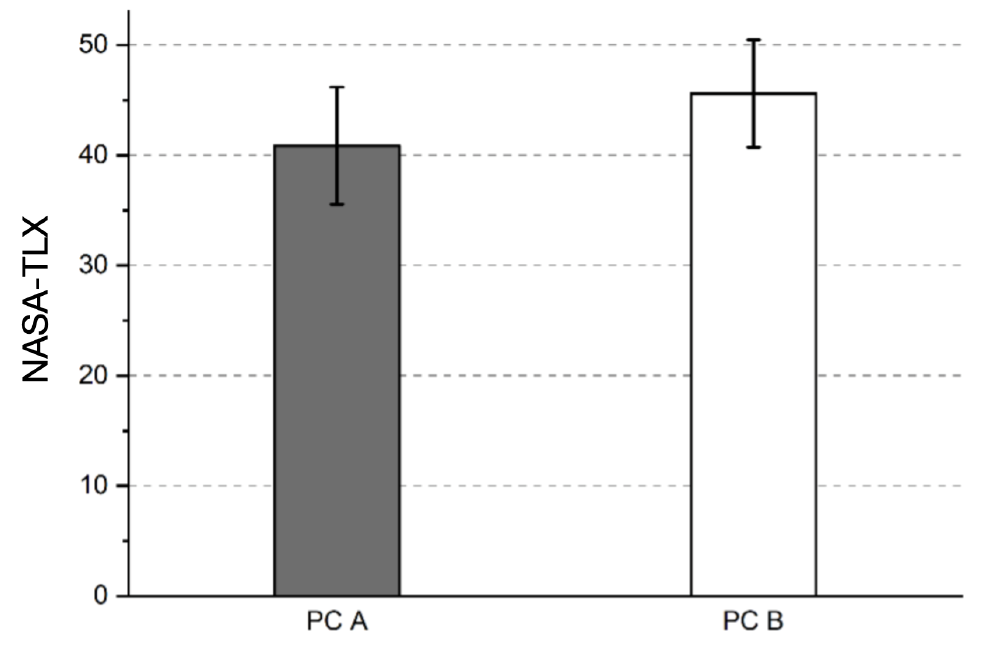
Figure 40. Weighted average score of NASA-TLX workload in PC assembly task.